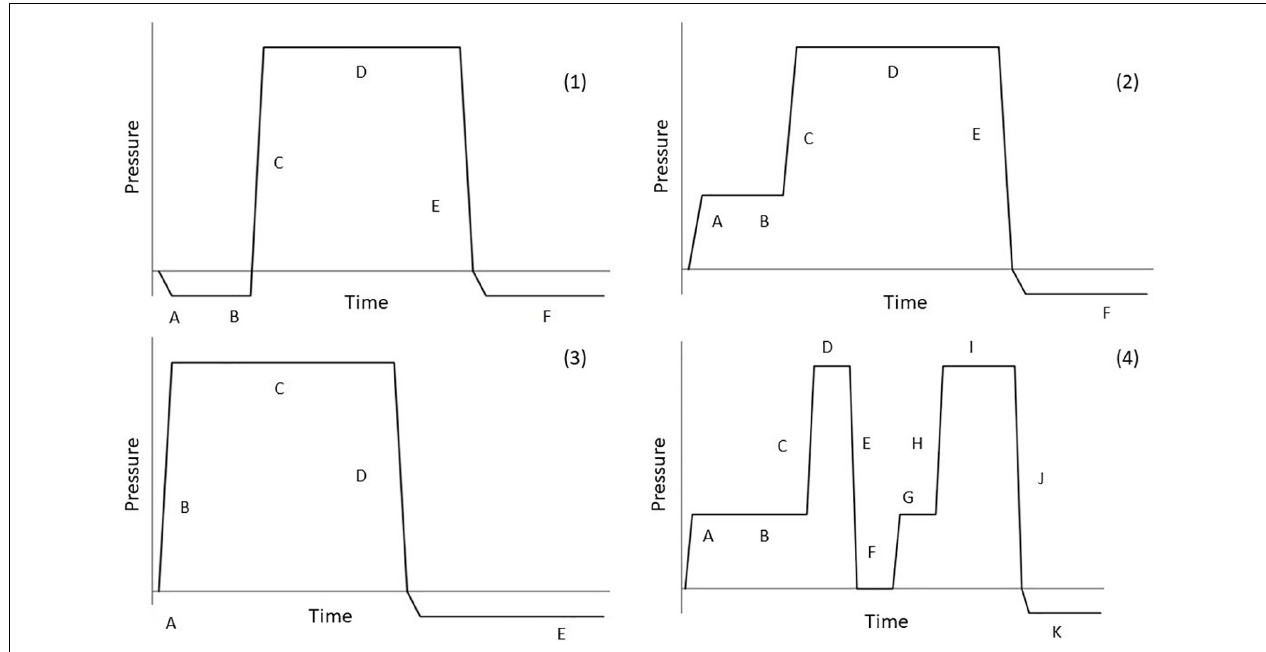
FIGURE 1 | (1) Diagram of a full cell process with an optional post vacuum with (A) pre-vacuum, (B) flooding the autoclave under maintenance of the vacuum, (C) released vacuum and increased liquid pressure, (D) maintenance of liquid pressure, (E) released liquid pressure and removing of the preservative, and (F) optional final vacuum; (2) Diagram of a Rüping process with (A) air pressure, (B) flooding the autoclave under maintenance of the air pressure, (C) increase of the liquid pressure, (D) maintenance of the liquid pressure, (E) released liquid pressure and removing of the preservative, and (F) required post vacuum; (3) Diagram of a Lowry process with (A) flooding the autoclave with preservative, (B) increase of the liquid pressure, (C) maintenance of the liquid pressure, (D) released liquid pressure and removing of the preservative, and (E) required post vacuum; (4) Diagram of an improved double Rüping process with (A) air pressure, (B) flooding the autoclave under maintenance of the air pressure and pre-heating of at least 150 min, (C) increase of the liquid pressure, (D) maintenance of the liquid pressure, (E) released liquid pressure and removing of the preservative, (F) atmospheric pressure of at least 30 min, (G) second air pressure, (H) applied liquid pressure, (I) second liquid pressure (twice as long as first liquid pressure), (J) released liquid pressure and removing of the preservative, and (K) required